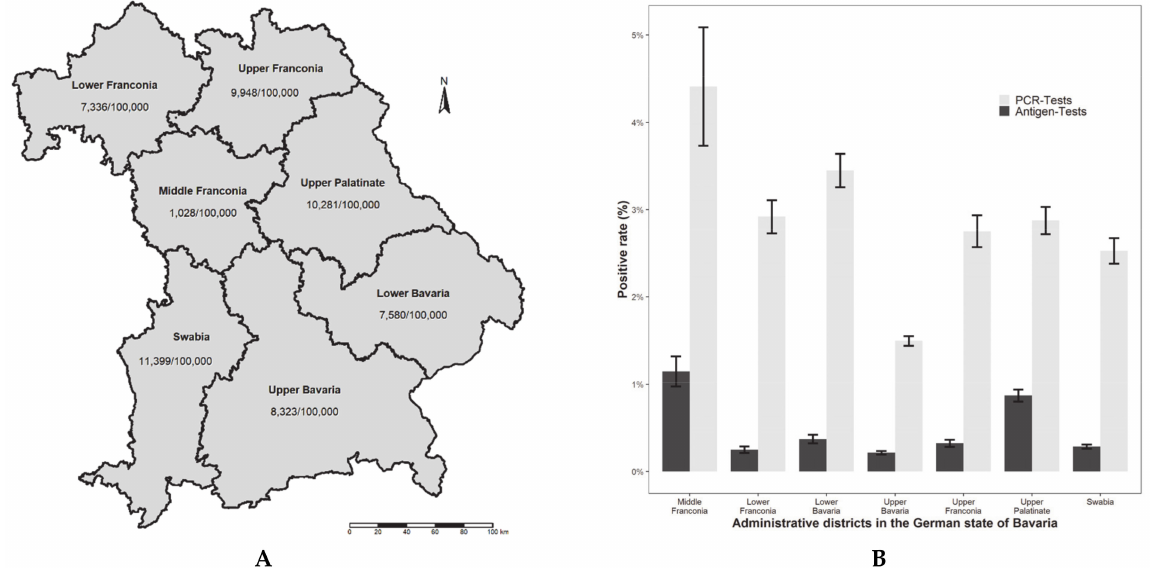
Figure 2. A . Accumulated number of serial screening tests (RT-PCR and antigen tests combined) of asymptomatic staff, patients/residents, and visitors in healthcare facilities in relation to 100,000 inhabitants for all seven administrative districts in the German state of Bavaria. B . Accumulated positive quotes with 95% confidence intervals (RT-PCR and antigen tests) of asymptomatic staff, patients/residents, and visitors in healthcare facilities in relation to 100,000 inhabitants for all seven administrative districts in the German state of